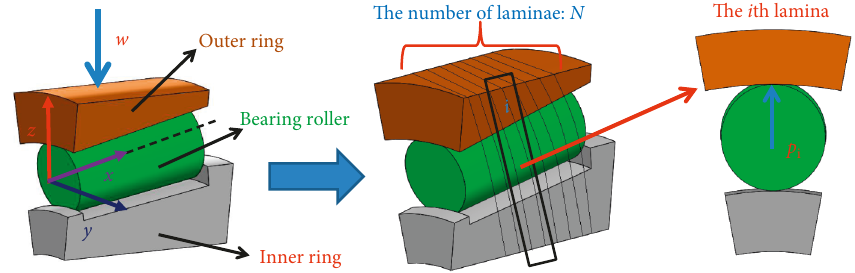
Figure 5: Schematic of line-load